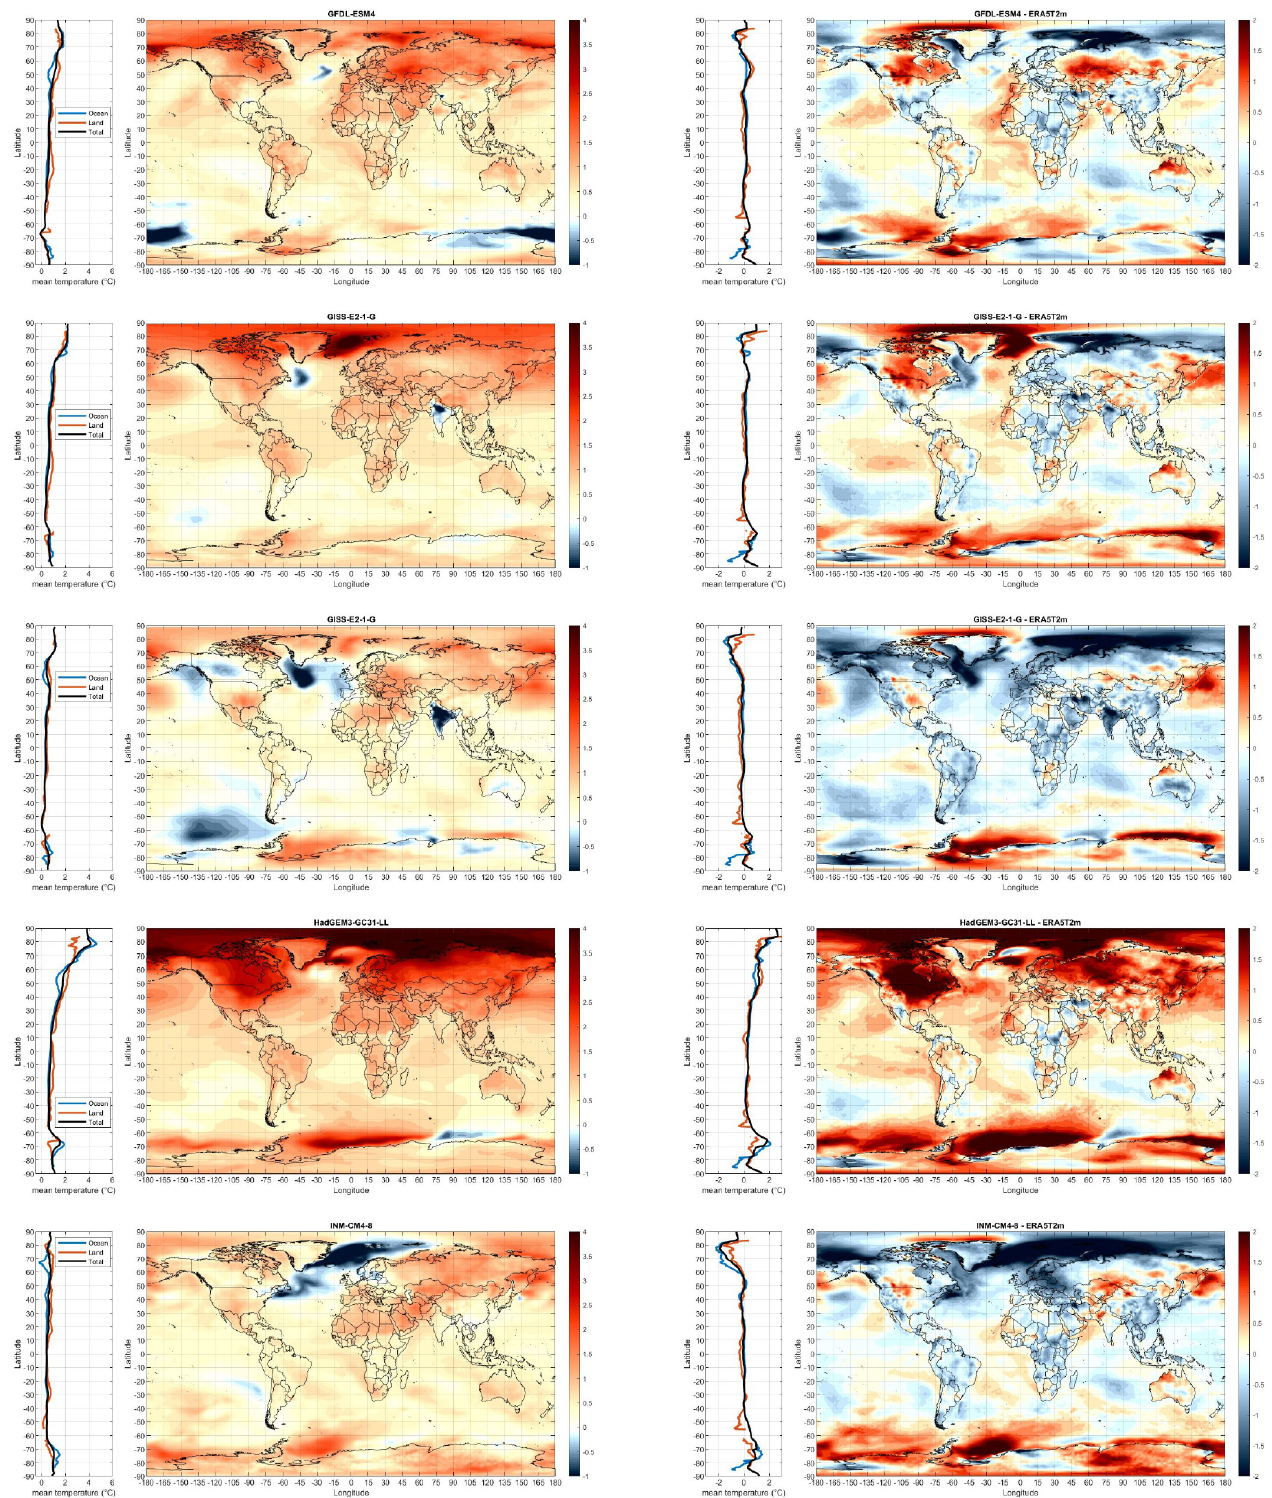
Figure A5. Warming patterns from 1980–1990 to 2011–2021 for the indicated CMIP6-tas GCM ( left ) and its comparison against the ERA5-T2m record ( right